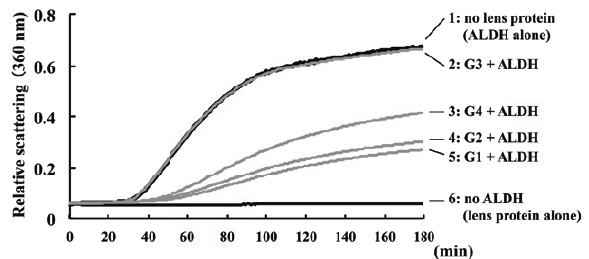
Figure 3: Chaperone activity of lens protein. The chaperone activity of water-soluble lens fractions was measured by a light scattering of ALDH at 360 nm, following the rat lens (day 6) administration of selenite or placebo. Curve 1 represents the light scattering of ALDH in the absence of lens protein. Curve 2 represents the light scattering of mixture of G3 lens protein (selenite treatment and no hesperetin treatment) and ALDH. Curve 3 shows the light scattering of mixture of G4 lens protein (selenite and hesperetin treatment) and ALDH. Curve 4 shows the light scattering of mixture of G2 lens protein (no selenite and hesperetin treatment) and ALDH. Curve 5 was shown the light scattering of mixture of G1 lens protein (no selenite and no hesperetin treatment) and ALDH. Curve 6 was shown the light scattering of lens protein without ALDH. Increasing of light scatting indicates the ALDH aggregation, and inhibition of light scattering depends on chaperone activity.